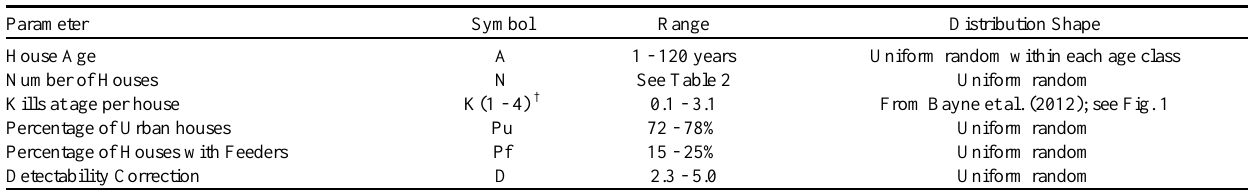
Table 3 . Input parameters for Monte-Carlo simulation for calculating collision mortality from houses in Canada.